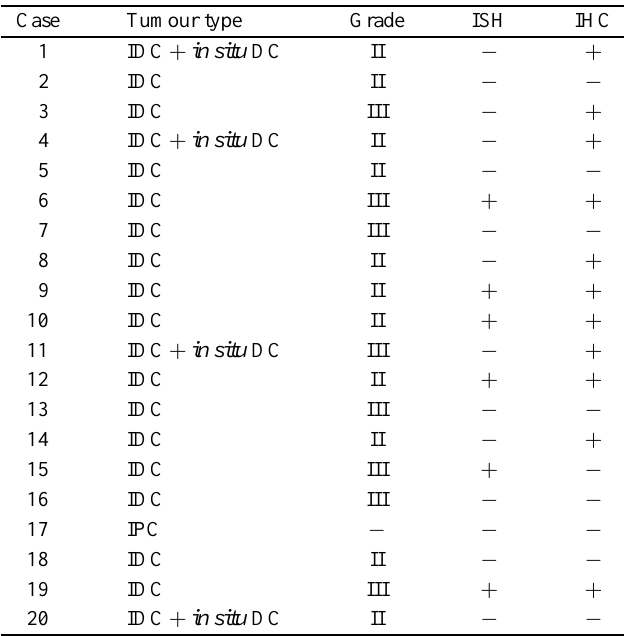
Correlation of c-erbB-2 overexpression of its mRNA by in situ hy- bridisation (ISH) and oncoprotein by immunohistochemistry (IHC) in various subtypes of breast